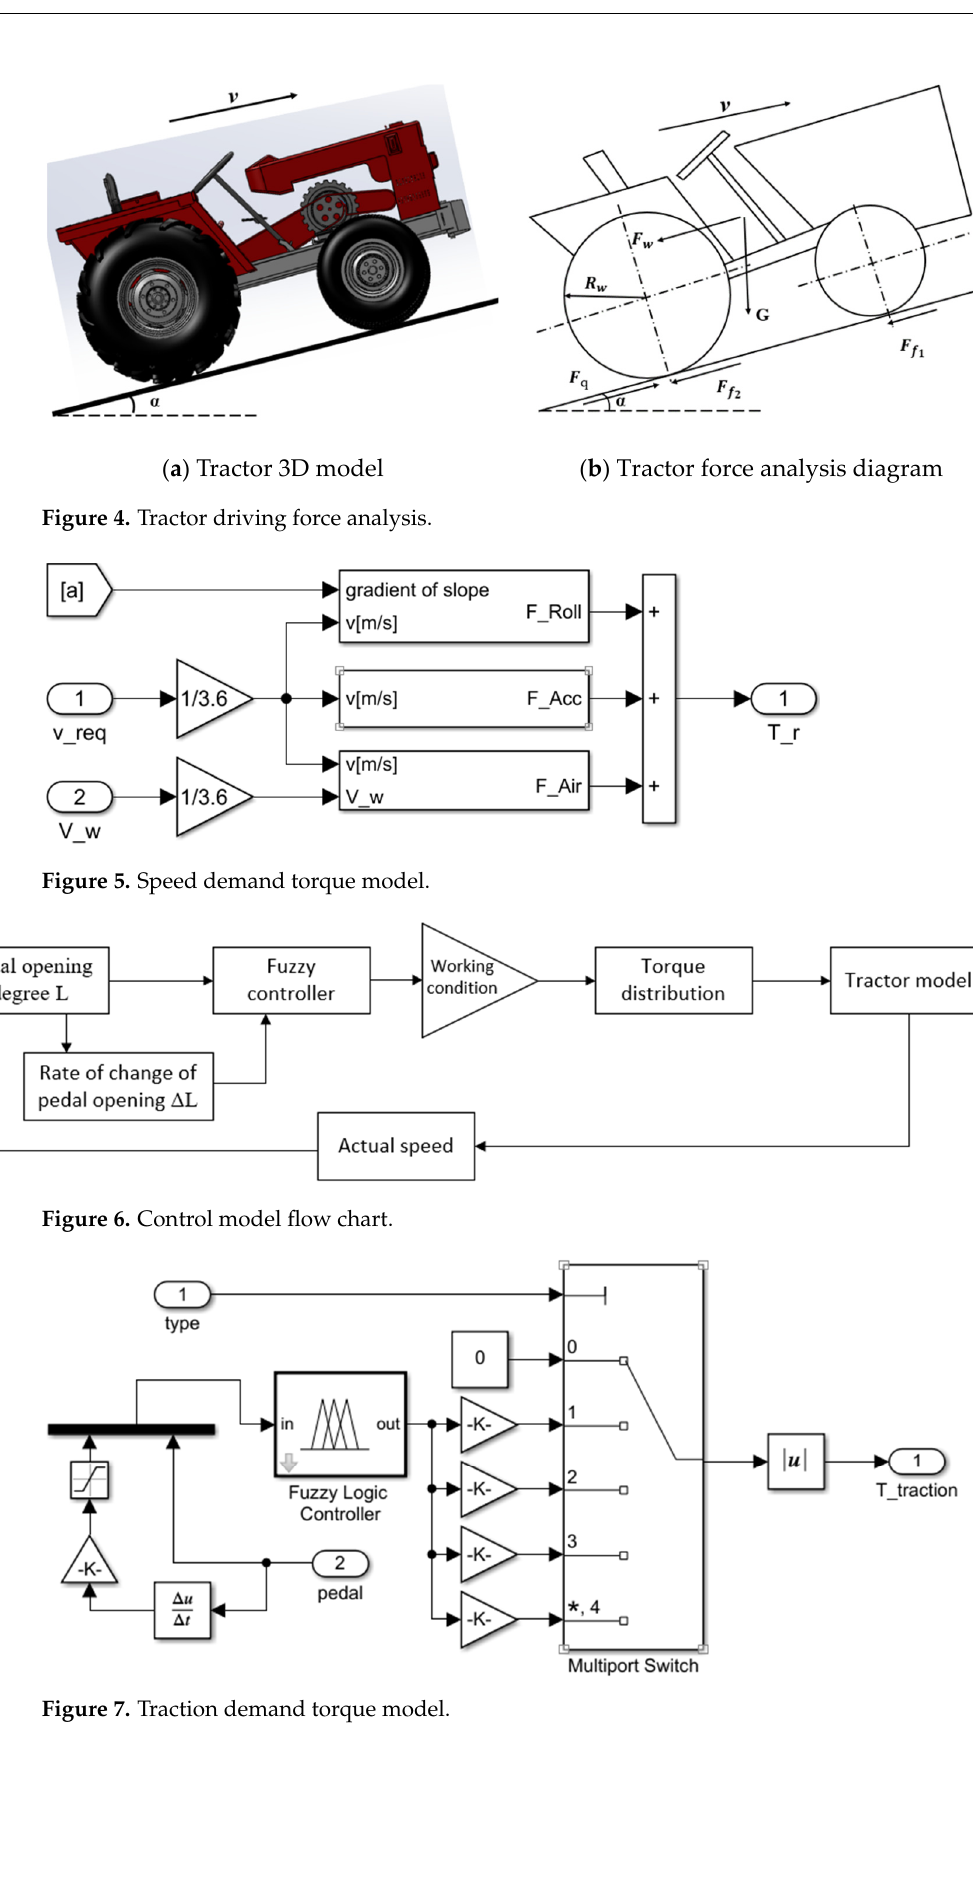
5 of 22 Figure 3. Demand torque calculation strategy model. 2.2.1. Basic Torque Calculation Module (1) Speed demand torque For the tractor, its speed demand torque needs to maintain a close relationship with the pedal opening to achieve real-time control of the electric tractor. The expression is as follows. 𝑇 (cid:3045) = 𝑇 (cid:3040)(cid:3028)(cid:3051) (cid:3400) 𝐿 (cid:4593)